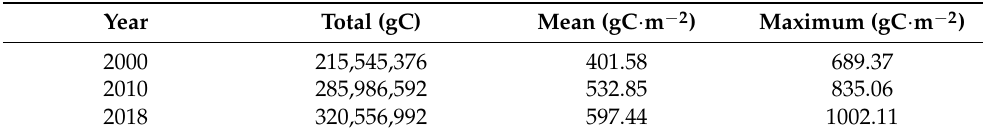
Table 7. NPP derived from the CASA model from 2000 to